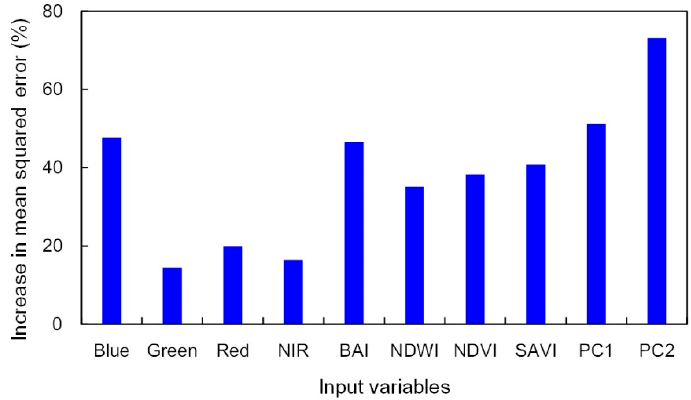
Figure 8. Variable importance scores averaged across all years for the RF-based method.